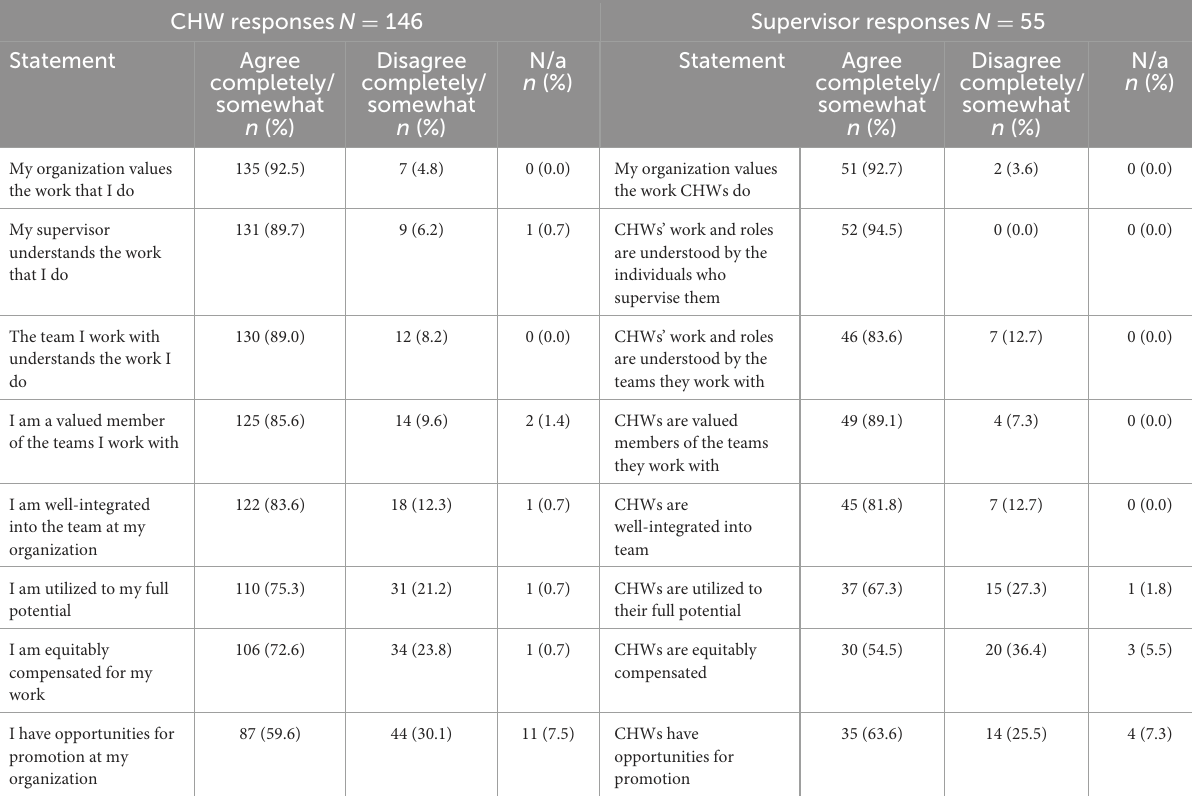
TABLE 6 Perception of CHW value and team integration among a national sample of CHWs and CHW supervisors working with Medicaid managed care organizations. CHW responses N =